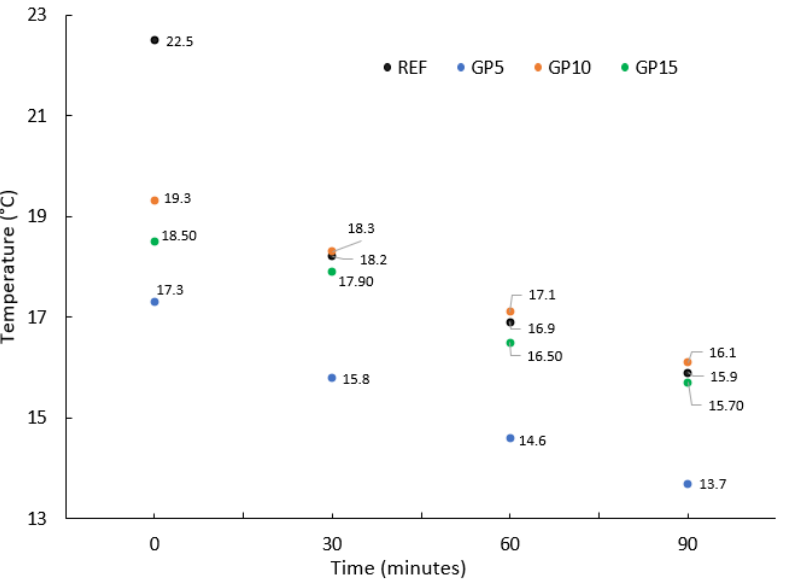
Figure 1. The temperature of the series of the cement mortar evaluated half an hour after the end of the mixing process and up to 2 h after the end of the mixing process.